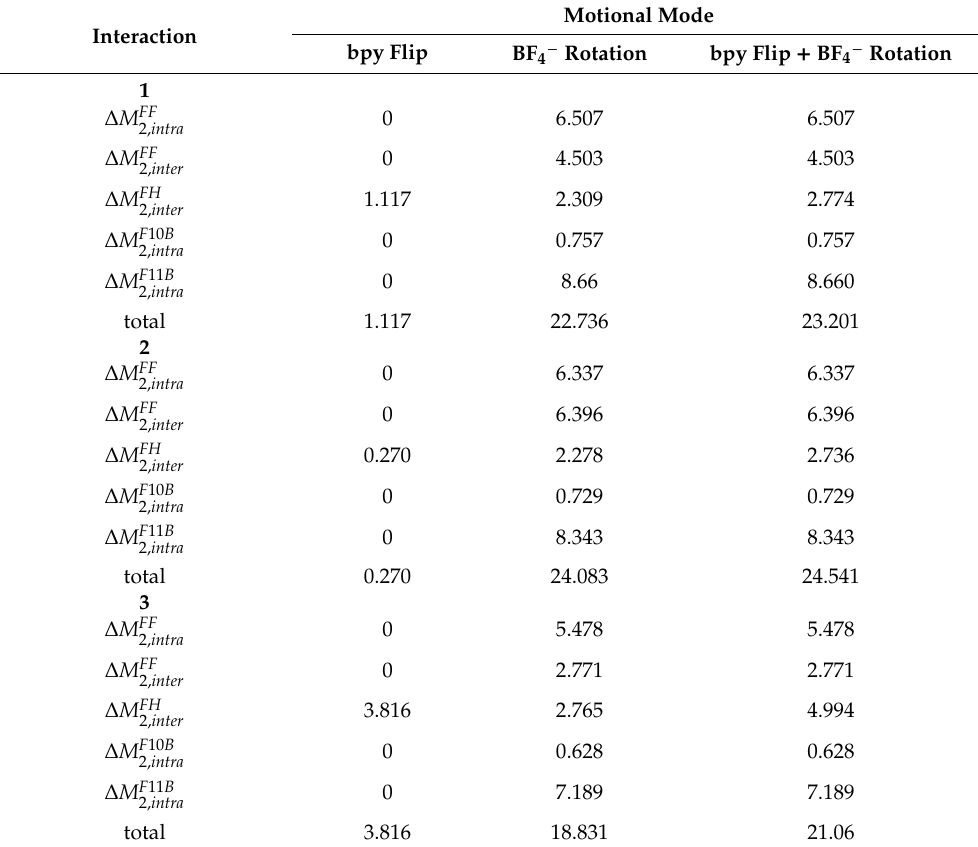
Table 2. Reductions in the 19 F second moments (in 10 − 8 T 2 ) in